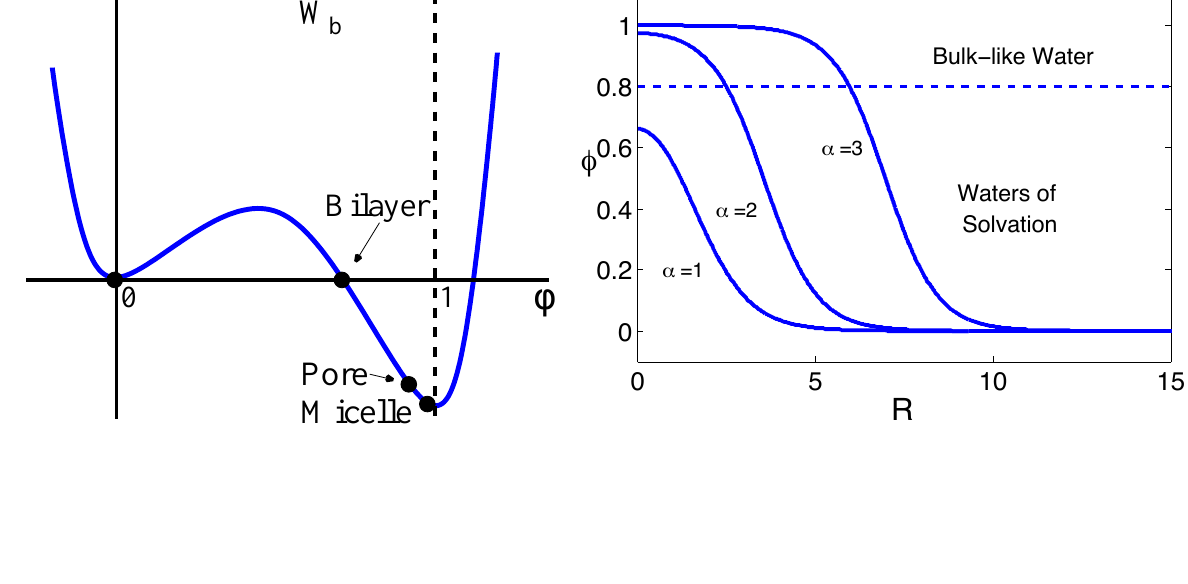
Figure 5. (Left) The tilted binary well W volume fraction for bilayers, pores, and micelles are indicated by solid dots, for bilayers this value occurs at the transverse zero of W lowest), pores ( α = 2 , middle), and micelles ( α = 3 , highest) for well-tilt τ = the higher co-dimension profiles accommodate bulk-like